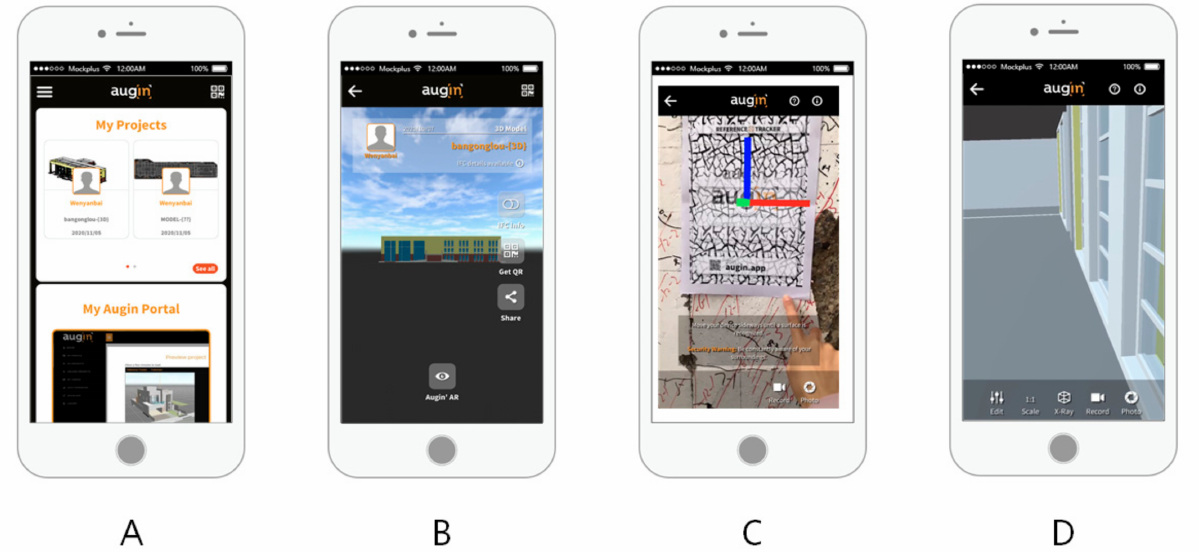
Figure 8. Viewing the model at 1:1 ratio: ( A ) Project list; ( B ) AR model; ( C ) Identify the reference; ( D ) View the model at 1:1